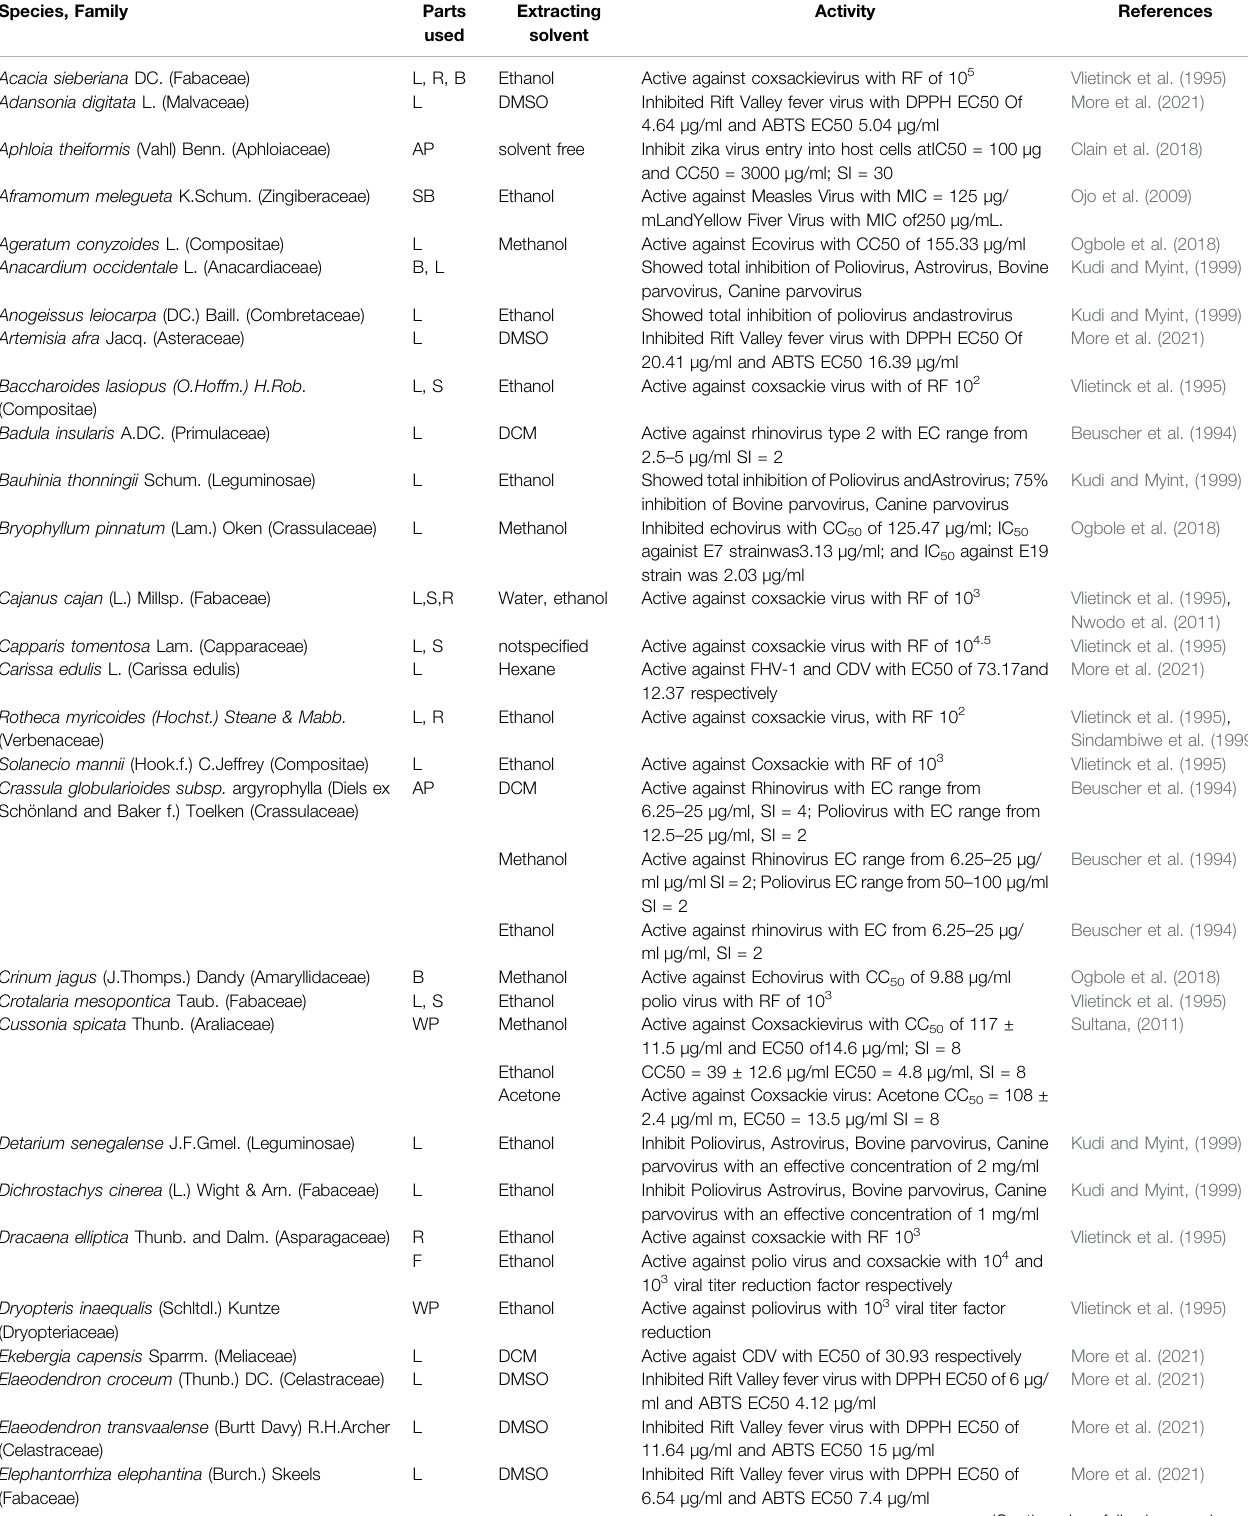
TABLE 4 | Antiviral activity of African medicinal plants against poliovirus, astrovirus, coxsackievirus, Rift Valley fever virus, zika virus, measle, echovirus, yellow fi ver virus, parvovirus, chikungunya virus, cytomegalovirus, CDV. Species,